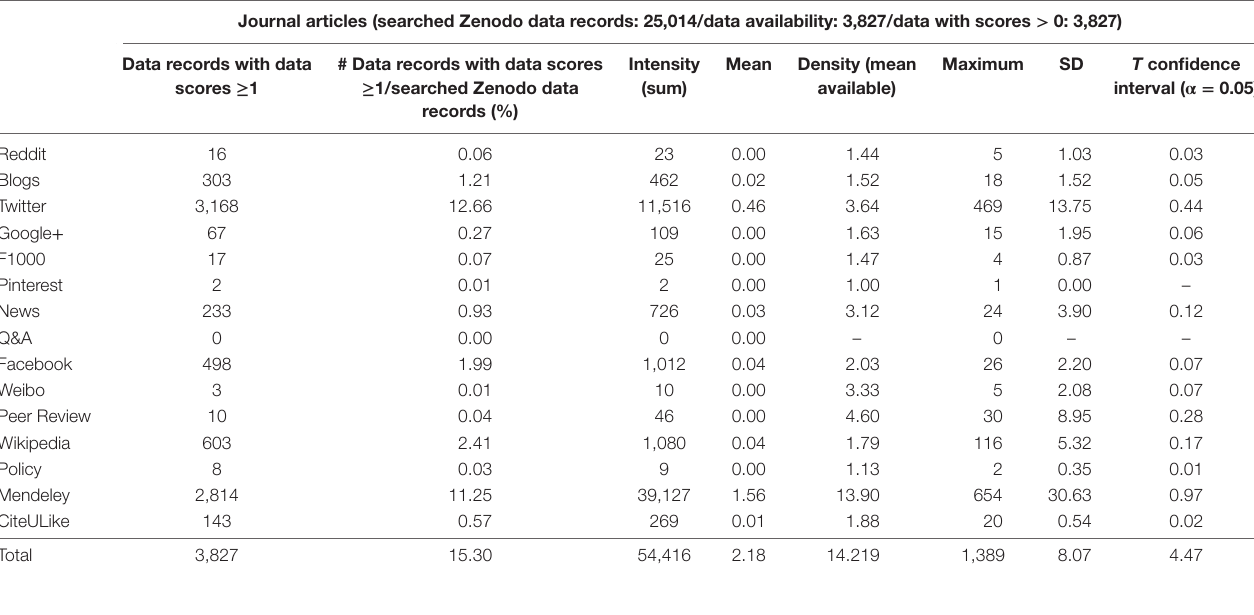
Table 8 | Results from Altmetric.com (Zenodo data record type: journal articles, publication years < 2016; see also Tables A8–A14 in Supplementary Material).